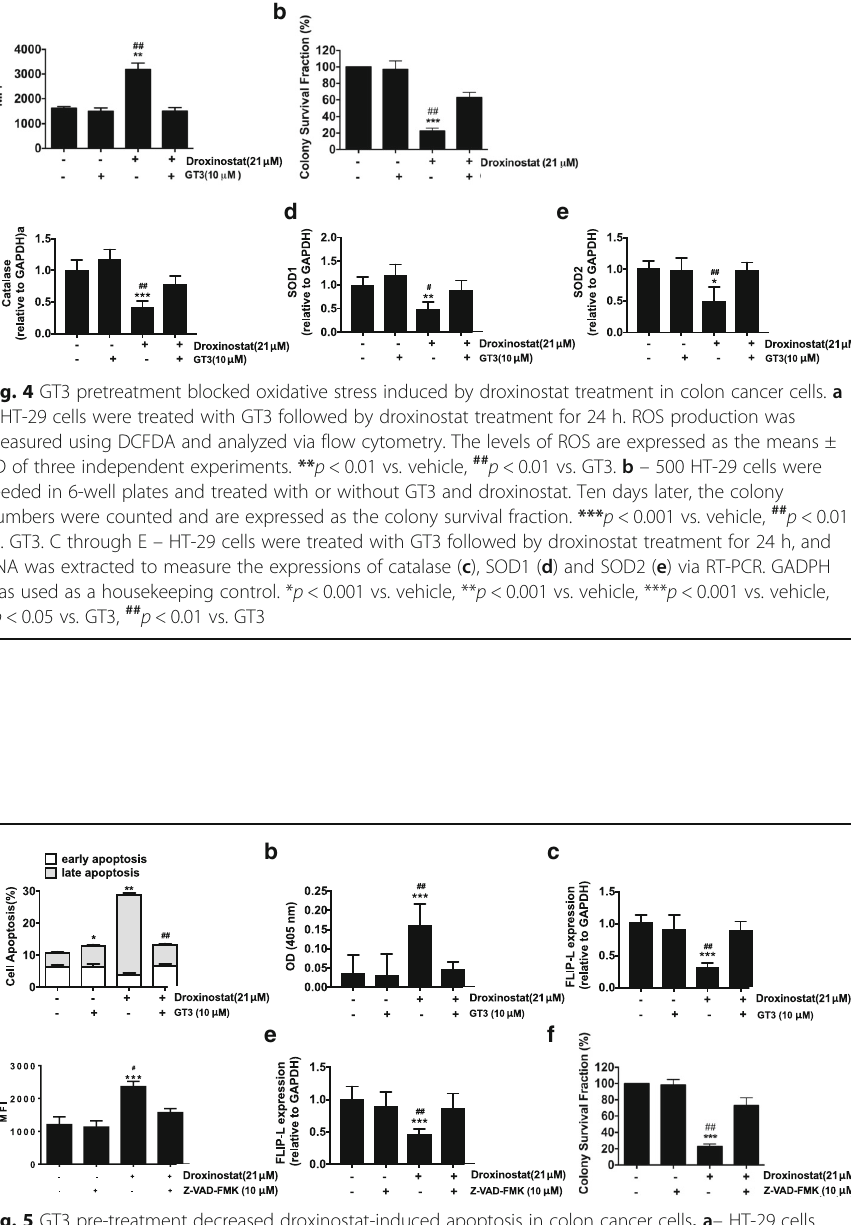
Fig. 5 GT3 pre-treatment decreased droxinostat-induced apoptosis in colon cancer cells . a – HT-29 cells were treated with 10 μ M GT3 followed by 21 μ M droxinostat treatment for 24 h. Cellular apoptosis was measured with annexin V and PI staining. Apoptotic data are expressed as the means ± SD of three independent experiments. * p < 0.05 vs. vehicle, ** p < 0.01 vs. vehicle, ## p < 0.01 vs. GT3. b – HT-29 cells were treated with 10 μ M GT3 followed by 21 μ M droxinostat treatment for 24 h. The activity of caspase-3 was measured at 405 nm and is expressed as optical density (OD). c – HT-29 cells were treated with 10 μ M GT3 followed by 21 μ M droxinostat treatment for 24 h. Expression of c-FLIP was assessed via RT-PCR. GADPH was used as a housekeeping control. *** p < 0.001 vs. vehicle, ## p < 0.01 vs. GT3. d – HT-29 cells were treated with 10 μ M Z-VAD-FMK followed by 21 μ M droxinostat treatment for 24 h. ROS production was measured using DCFDA and analyzed via flow cytometry. The levels of ROS are expressed as the means ± SD of three independent experiments. *** p < 0.001 vs. vehicle, # p < 0.05 vs. droxinostat. e – HT-29 cells were treated with 10 μ M Z-VAD-FMK followed by 21 μ M droxinostat treatment for 24 h. Expression of c-FLIP was assessed via RT-PCR. f – 500 HT-29 cells were seeded in 6-well plates and treated with or without Z-VAD-FMK and droxinostat. Ten days later, the colony numbers were counted and are expressed as the colony survival fraction. *** p < 0.001 vs. vehicle, ## p < 0.01 vs.